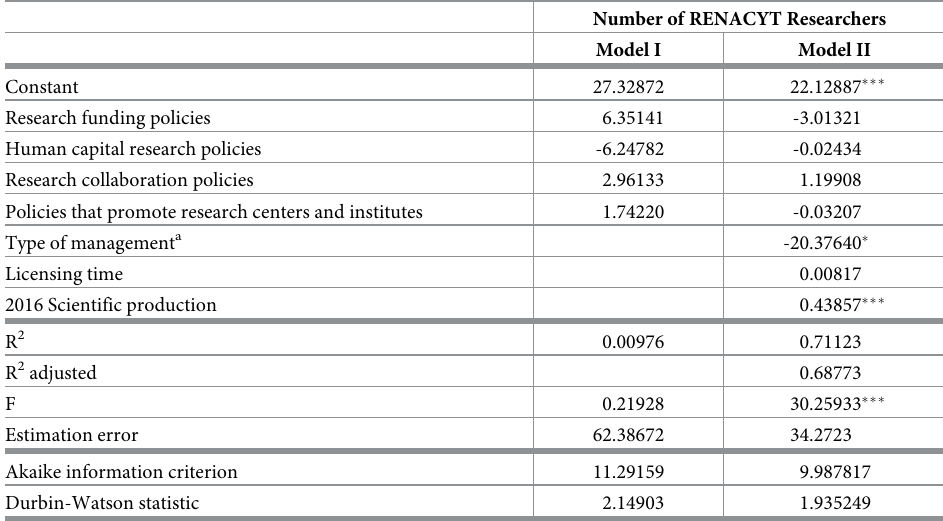
Table 4. Influence of research policies on the number of RENACYT researchers in Peruvian universities and grad- uate